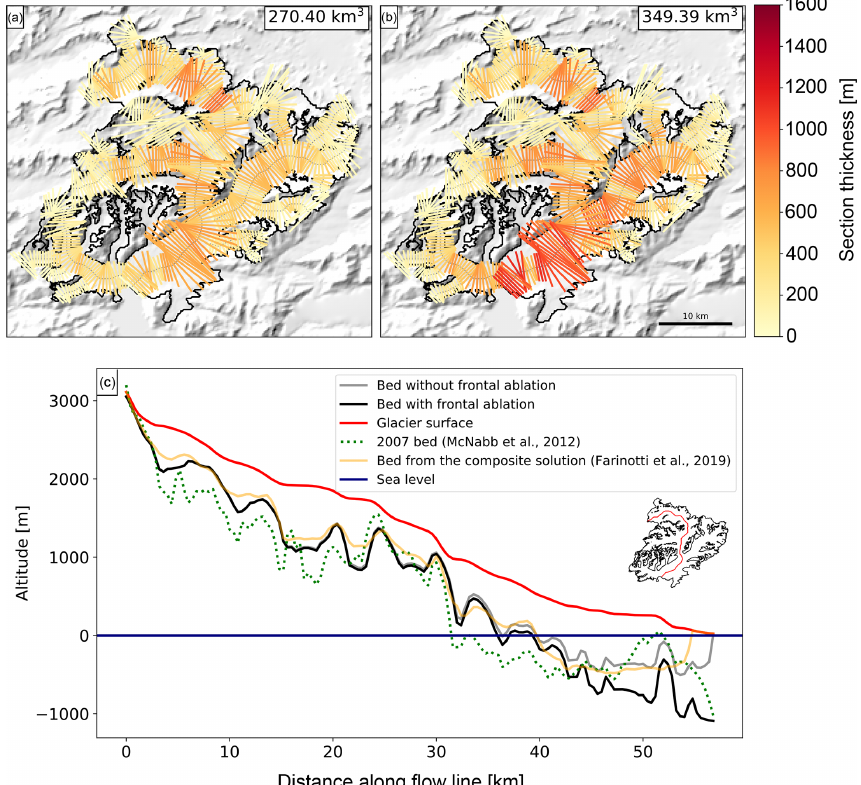
Figure 4. Ice thickness inversion results for Columbia Glacier. (a) Thickness distribution before accounting for frontal ablation. (b) Thickness distribution after accounting for frontal ablation, with a frontal ablation flux computed by the model of 2.98km 3 y − 1 . (c) Columbia Glacier main centre line profile, comparison between the 2007 estimated bed map (green doted line) from McNabb et al. (2012), the consensus estimate from Farinotti et al. (2019) (orange line), and model output before accounting for frontal ablation (grey line) and after accounting for frontal ablation (black